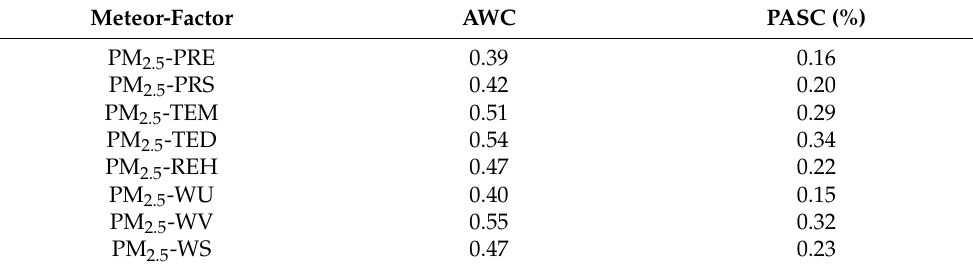
Figure 7. Wavelet transform coherence of PM 2.5 and single meteorological factor. Table 1. AWC and PASC for wavelet transform coherence.